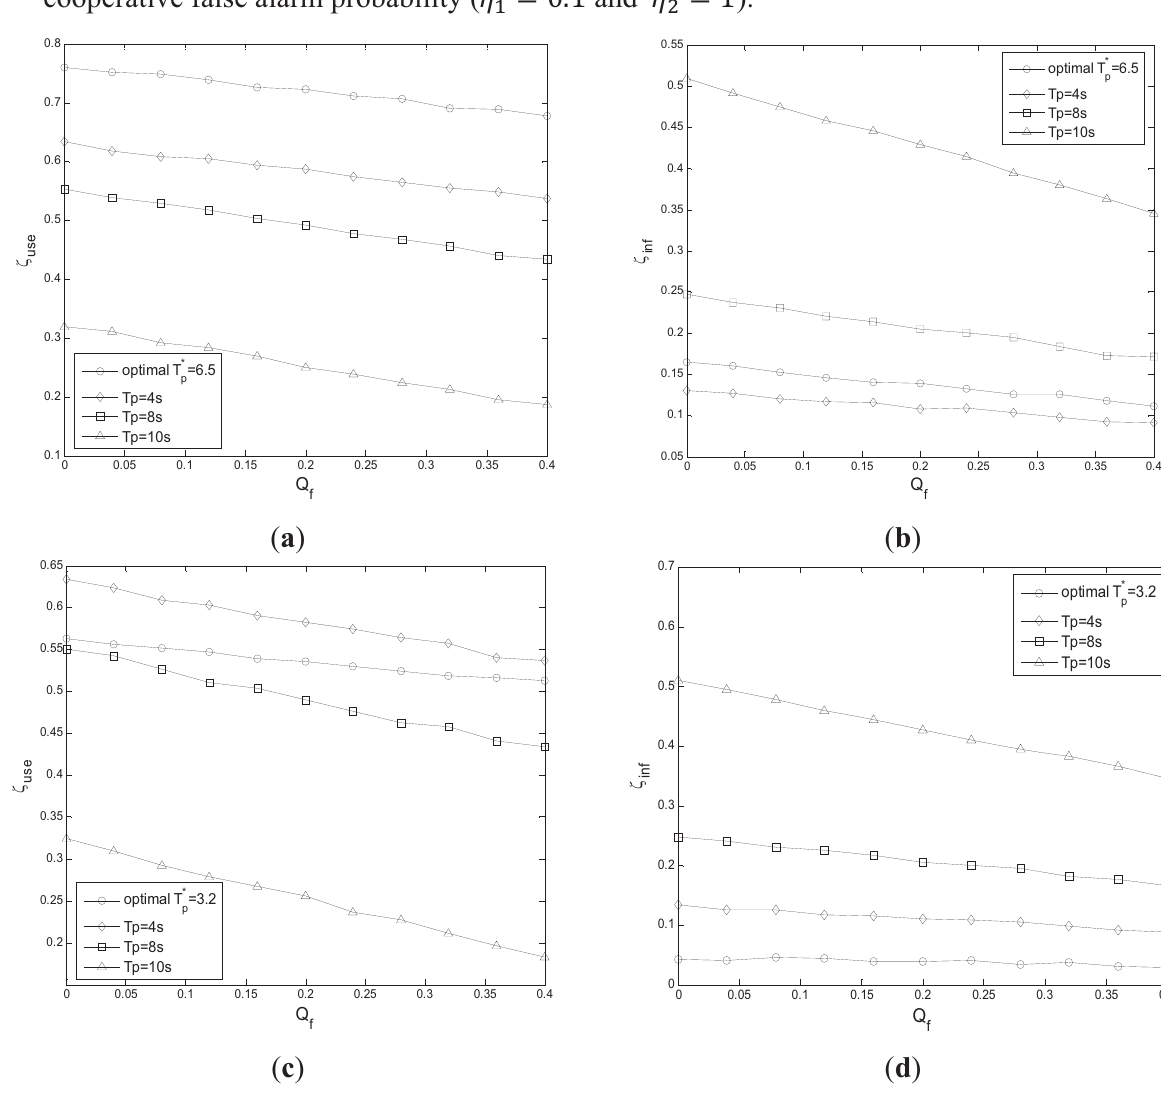
Figure 8. ( a ) Probability of spectrum utilization vs. cooperative false alarm